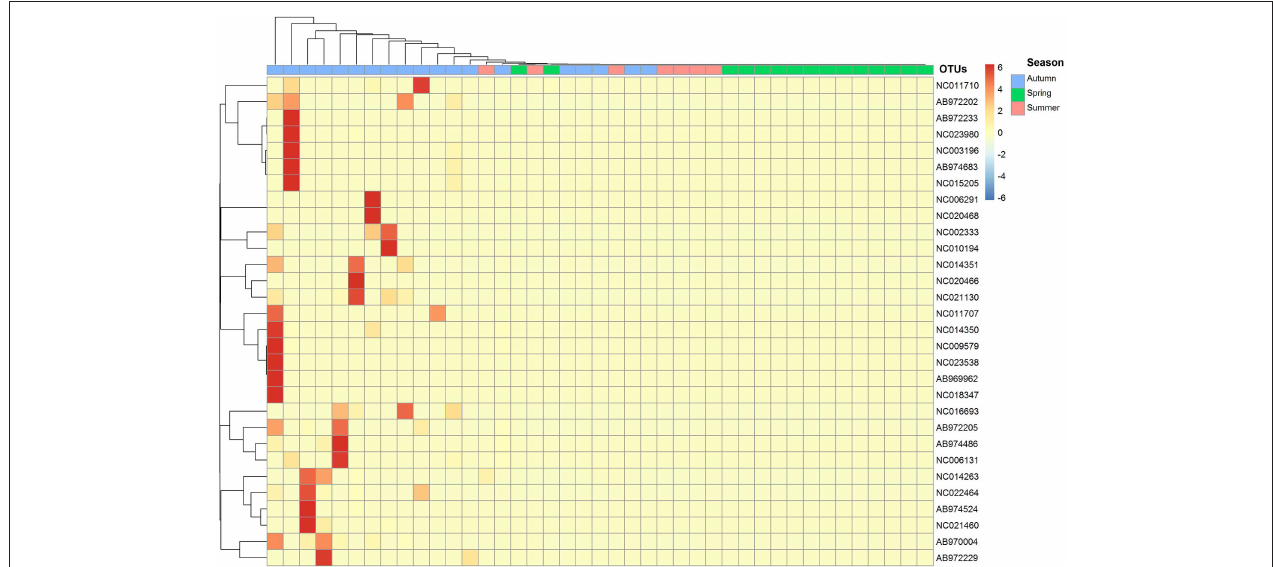
TABLE 4 | Conditional effects and correlations of environmental variables by CCA.